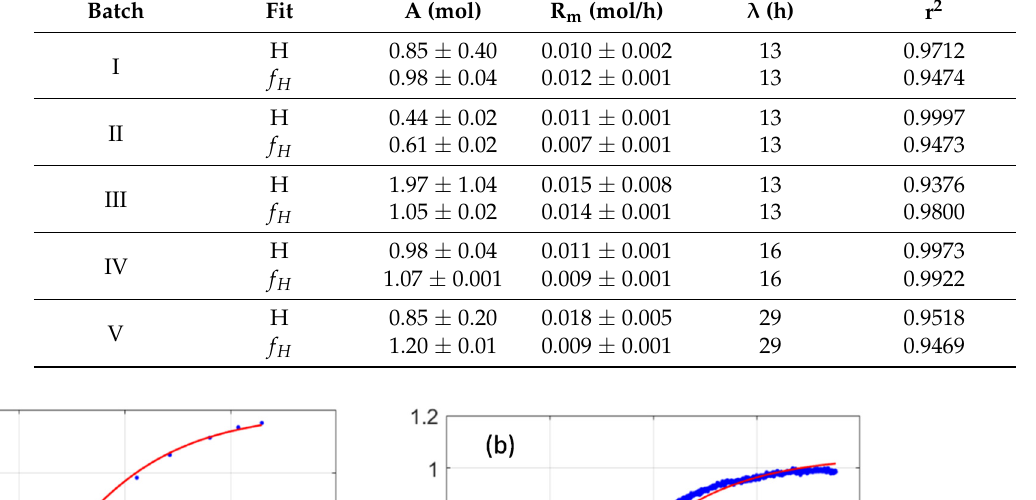
Table 3. Summary of modified Gompertz model parameters, setting the lag time. Batch